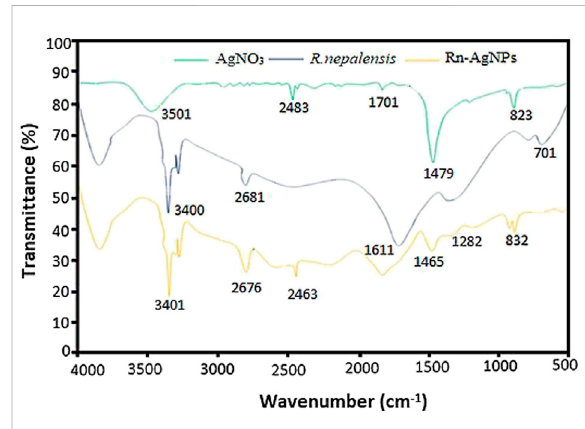
FIGURE 4 Comparison of the FTIR spectra of the R. nepalensis extract, AgNO 3 and Rn-AgNPs. Each peak in the Rn-AgNPs indicates the functional group of the phytochemical involved in the nanoparticle